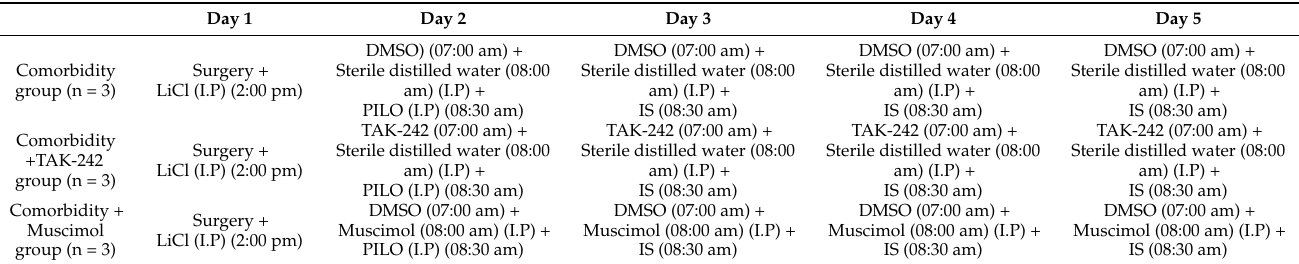
Table 2. Establishment of animal model (drug